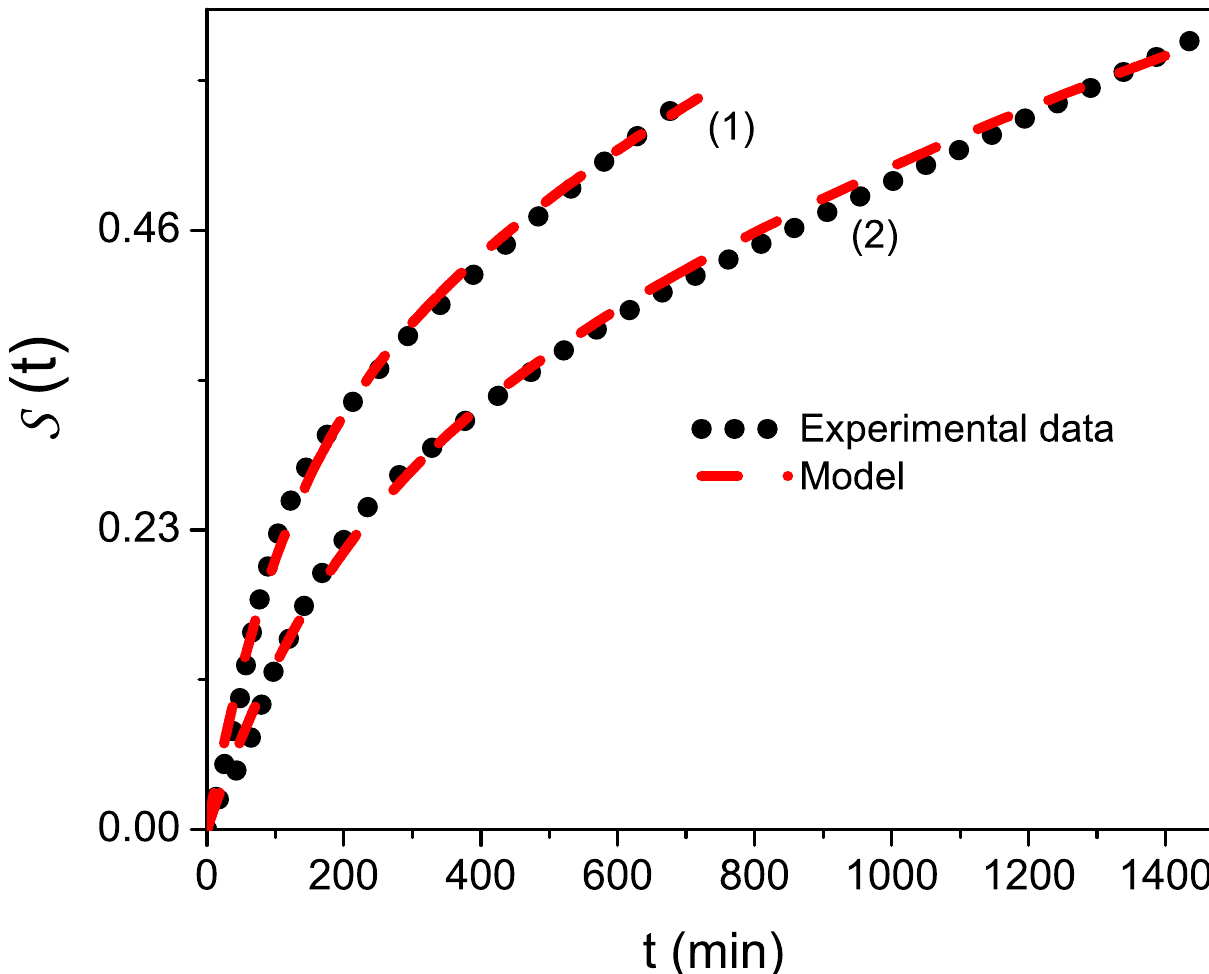
Fig 4. Model and experimental data. This figure compares the proposed model with experimental data present in Ref.[16], where (1) corresponds to MC5 and (2) to MC3. We have used in both cases k s ( p ) = 0 and k d ( p )/ p 2 = ( p+k 1 )/( k 2 p+k 3 ). For formulation MC5 (1), we